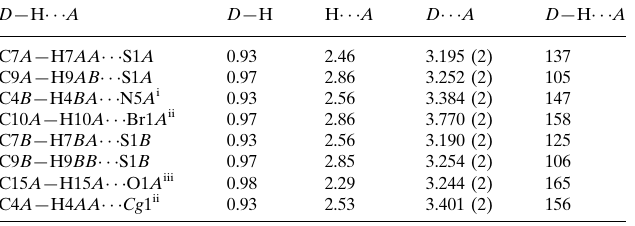
Hydrogen-bond geometry (A˚ , (cid:1)